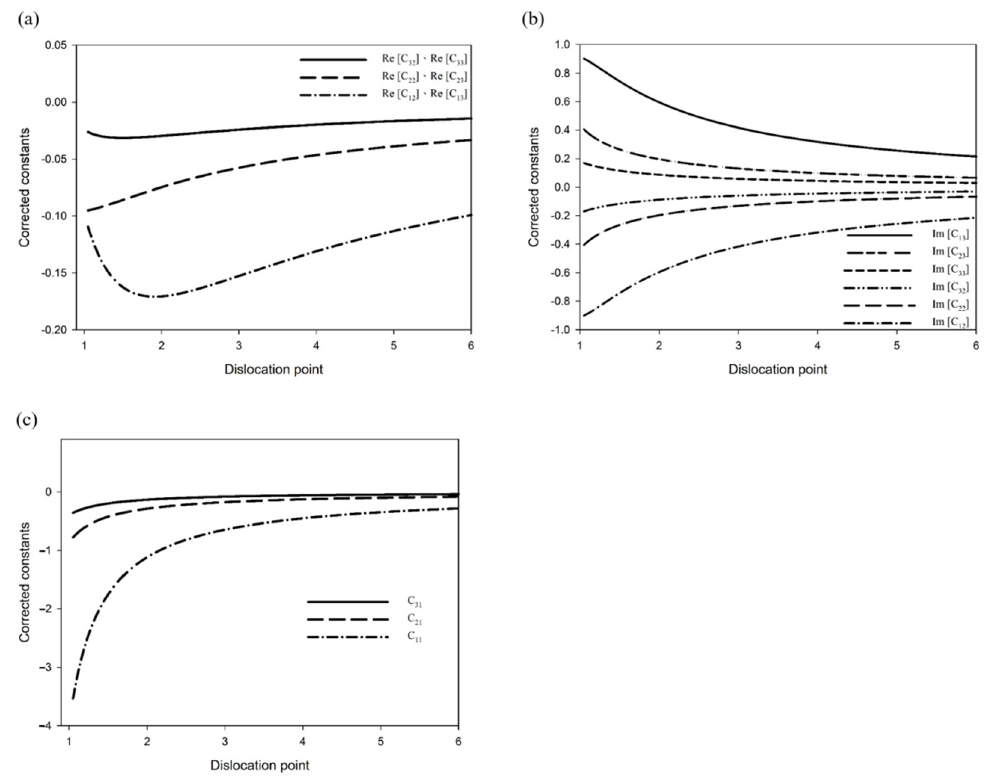
Figure 6. ( a ) Real parts of the constants ( C n 2 and C n 3 ); ( b ) imaginary parts of the constants ( C n 2 and C n 3 ); ( c ) constants ( C n 1 ) for a triangular hole problem ( w = 0.15, G b / G a = 2, r = 1.05).